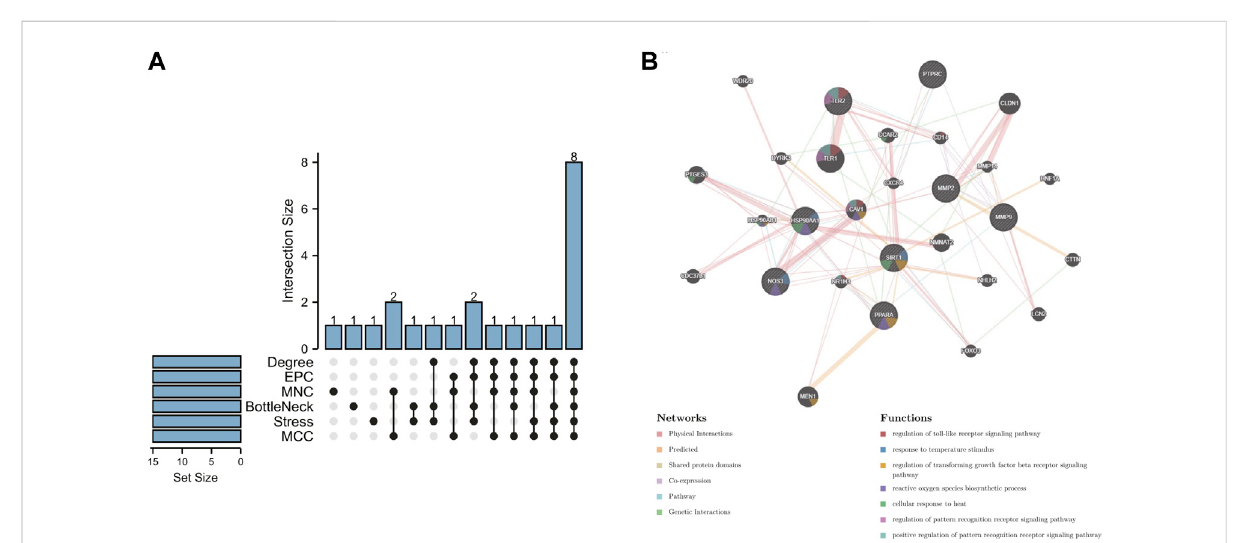
FIGURE 5 4-OI anti-sepsis Venn map and Hub gene coexpression network map. (A) The Venn map drawn by the R language package shows that six algorithms screened eight crossover Hub genes. (B) GeneMANIA analyzed the hub gene and its coexpression